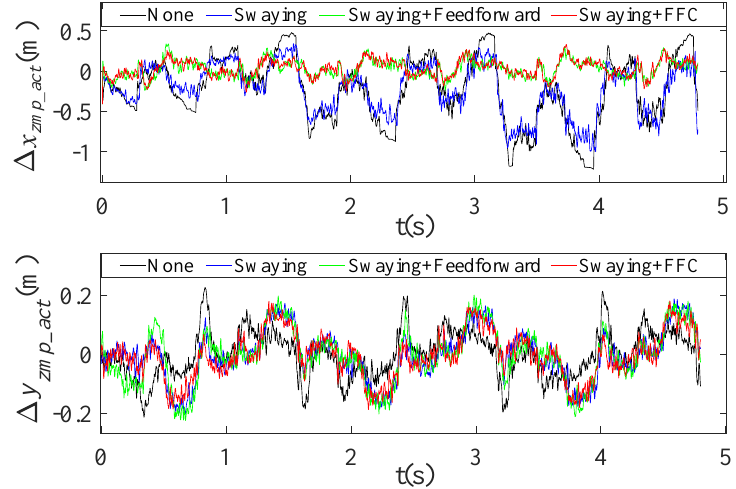
Figure 15. Actual ZMP tracking errors in crawling motion at the speed of 0.68 km/h with a 20 kg load.